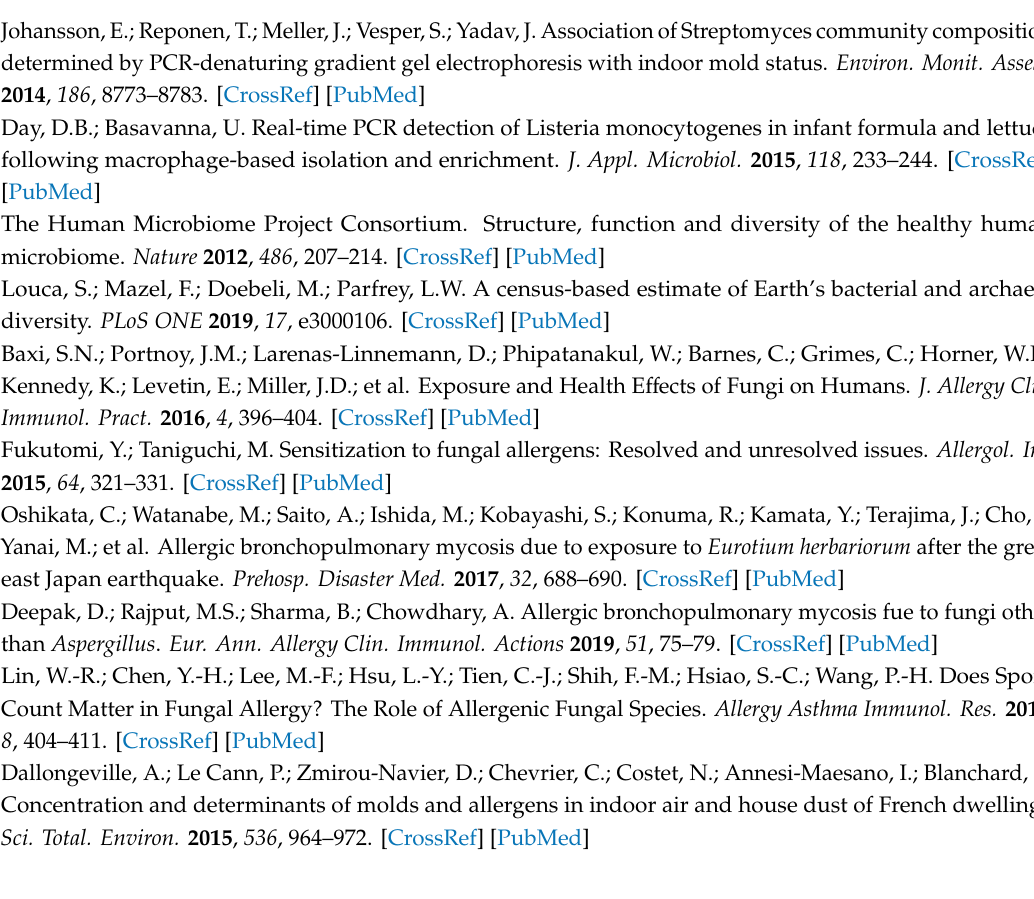
Table S1: Numbers of analyzed and assigned reads, following the removal of database sequences not classified at the genus level, Table S2: The relative abundance of fungi that are often observed in culture method., Table S3: The relative abundance of medically important